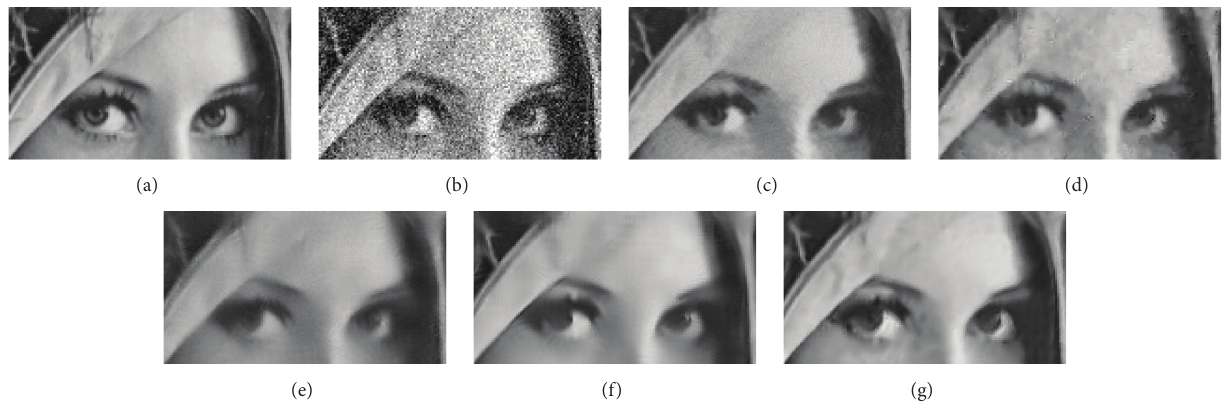
Figure 3: Detailed comparison of the proposed approach with other approaches on image Lena with 𝜎 = 30 : (a) is the noise-free image; (b) is the corrupted image; (c)–(f) are the denoising results by NLM, NL-TV, NLMPCA, and NLMSAP; (g) is the denoising result by the proposed 𝑙 0